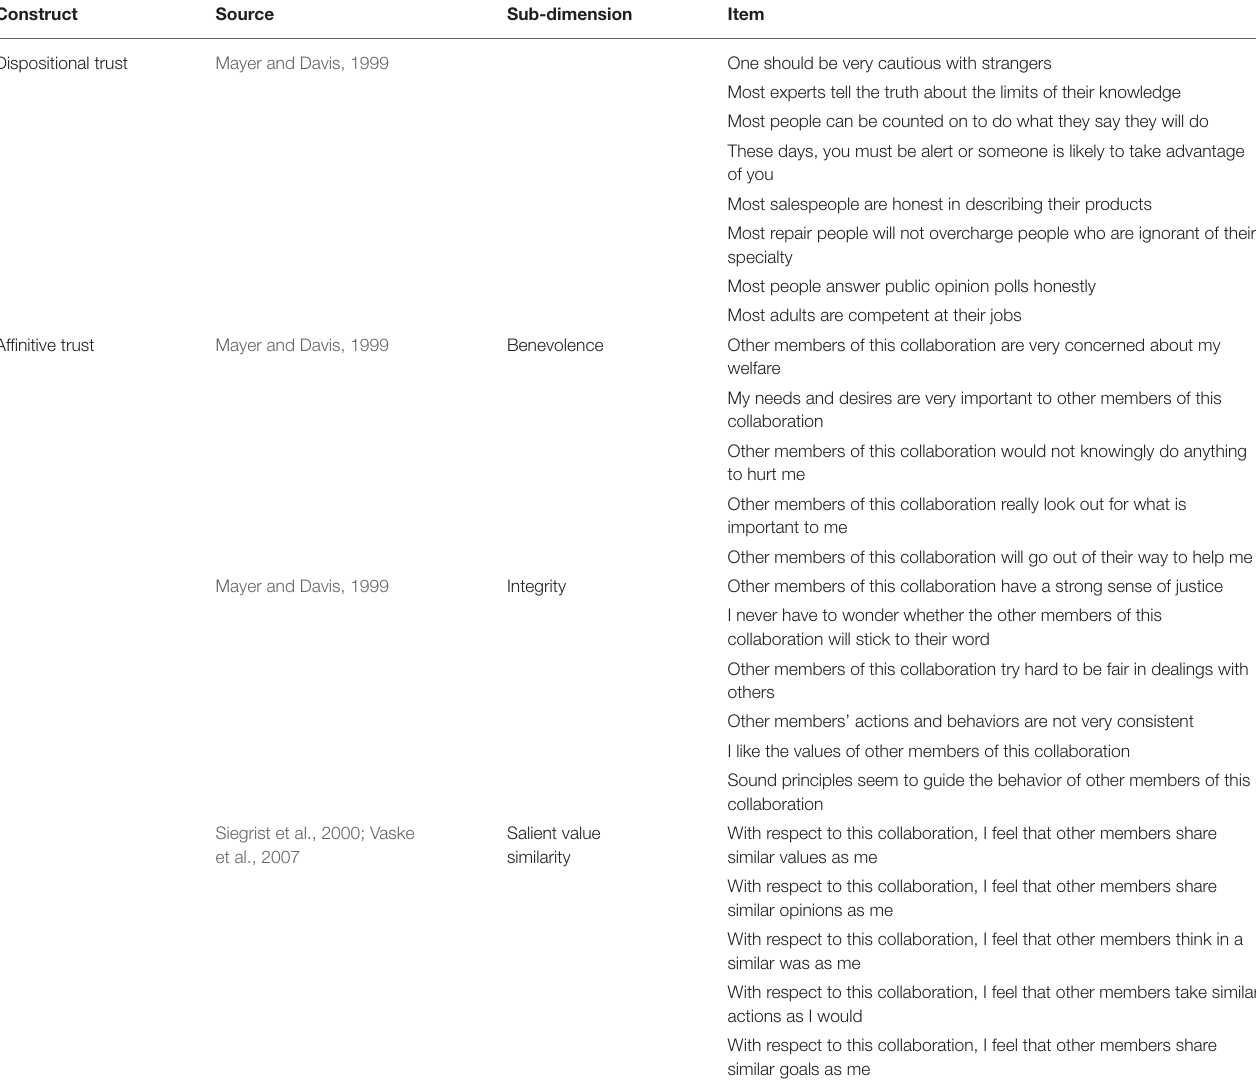
TABLE 1 | Measures of dispositional and affinitive